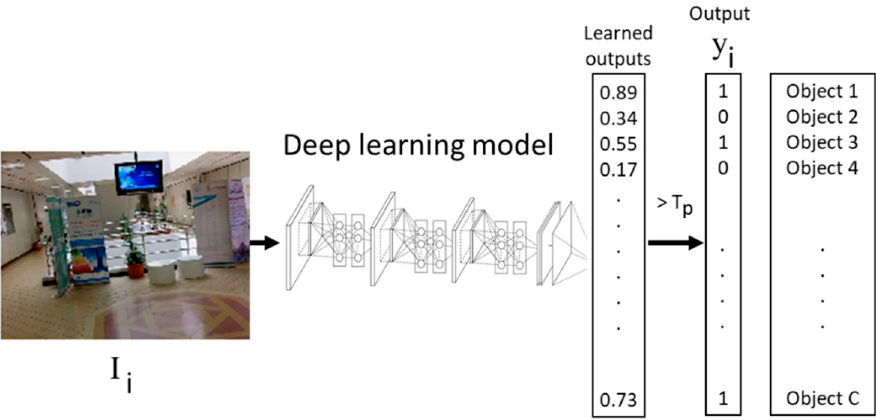
Figure 1. Overview of the image multi-labeling problem.